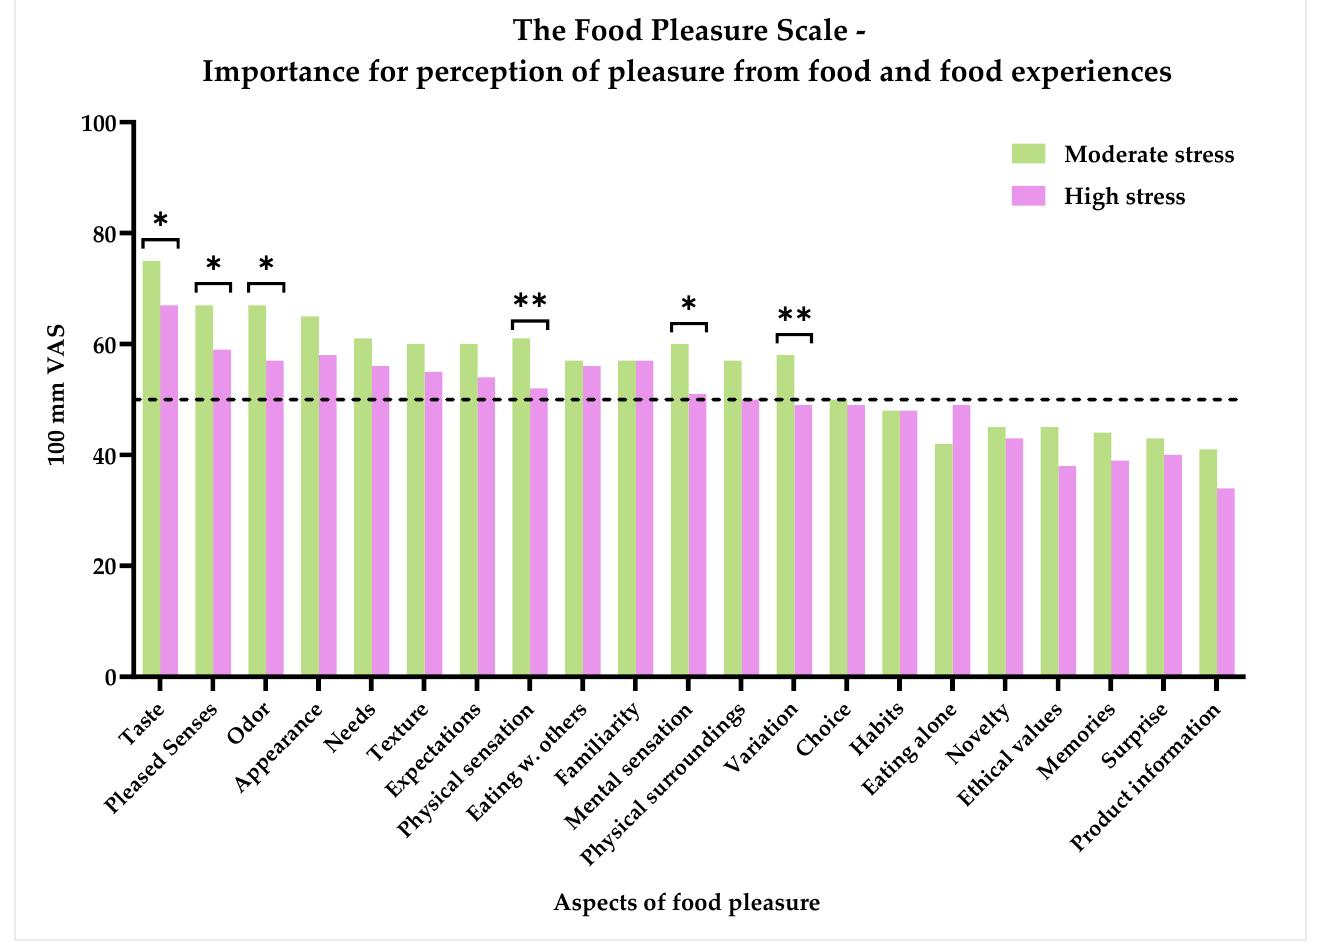
Figure 5. Subjective importance of pleasure from food and food experiences by the 21 different pleasure aspects of the Food Pleasure Scale rated on a 100 mm VAS scale anchored by ‘Not important at all’ and ‘Extremely important’. Results are shown for the two groups based on the results of the PSS-10: ‘Moderate stress’ ( n = 116) and ‘High stress’ ( n = 74). Stars indicate level of significance of p -values. *: p < 0.05, **: p < 0.01. Dotted line marks 50% frequency.